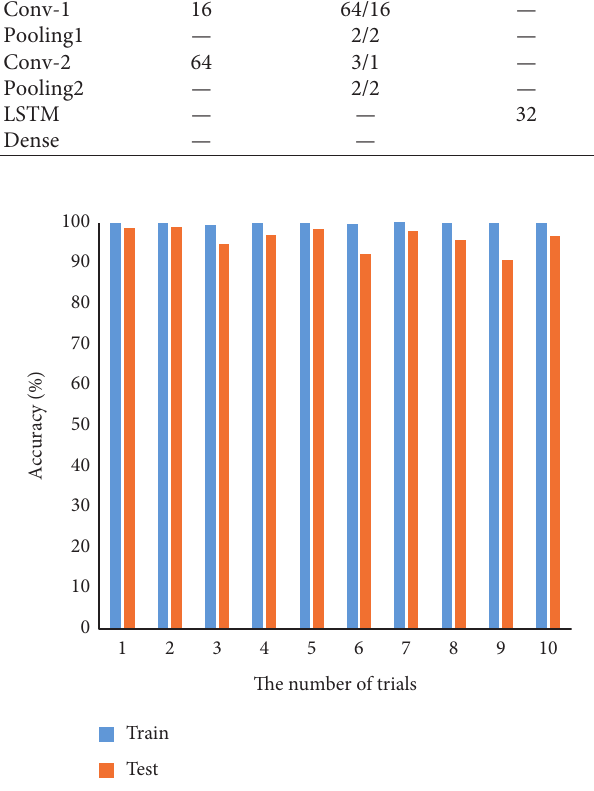
Figure 8: Performance of the proposed model in TCM for the 8mm tool.